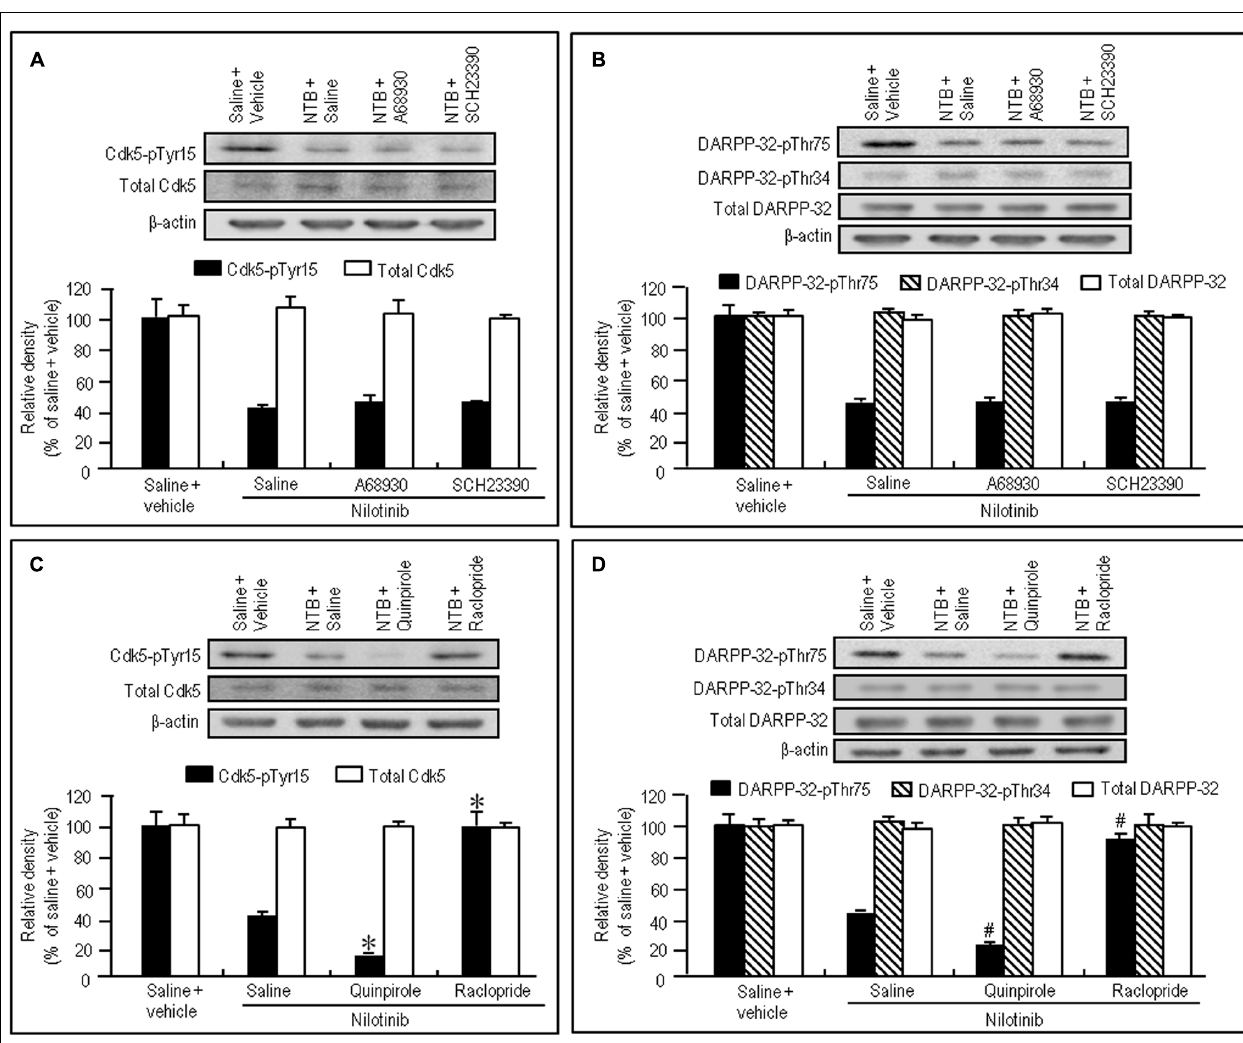
with saline + vehicle, NTB + saline, NTB + A-68930, or NTB + SCH-23390. Values are means ± SEM ( n = 5). (C) Western blot analysis of striatal levels of Cdk5-pTyr15 and total Cdk5 in mice treated with saline + vehicle, NTB + saline, NTB + quinpirole, or NTB + raclopride.Values are means ± SEM ( n = 5). * P < 0.05 versus mice treated with NTB + saline; one-way ANOVA [ F ( 3,16 ) = 44.790] followed by Scheffe test. (D) Western blot analysis of striatal levels of DARPP-32-pThr75, DARPP-32-pThr34, and total DARPP-32 in mice treated with saline + vehicle, NTB + saline, NTB + quinpirole, or NTB + raclopride. # P < 0.05 versus mice treated with NTB + saline; one-way ANOVA [ F ( 3,16 ) = 116.883] followed by Scheffe